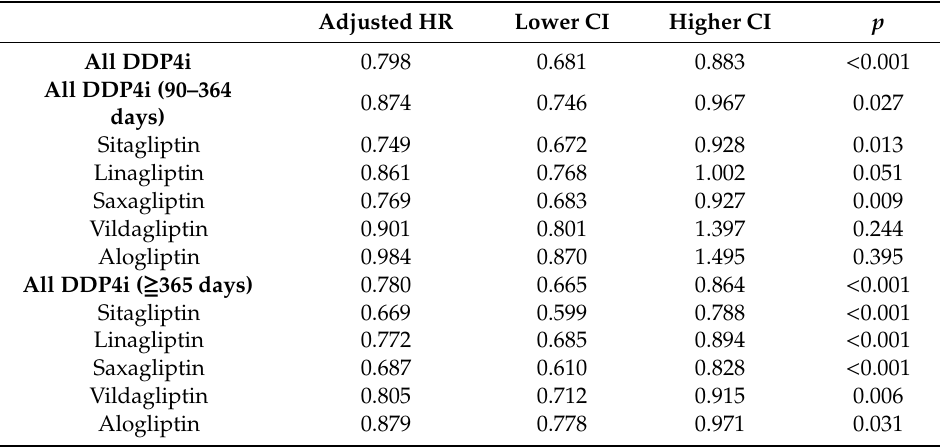
Table 4. Comparison of the risk for dementia according to the use of